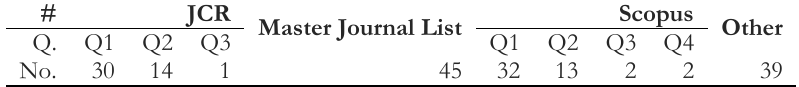
Table 1. Number of papers published in journals with different indices.